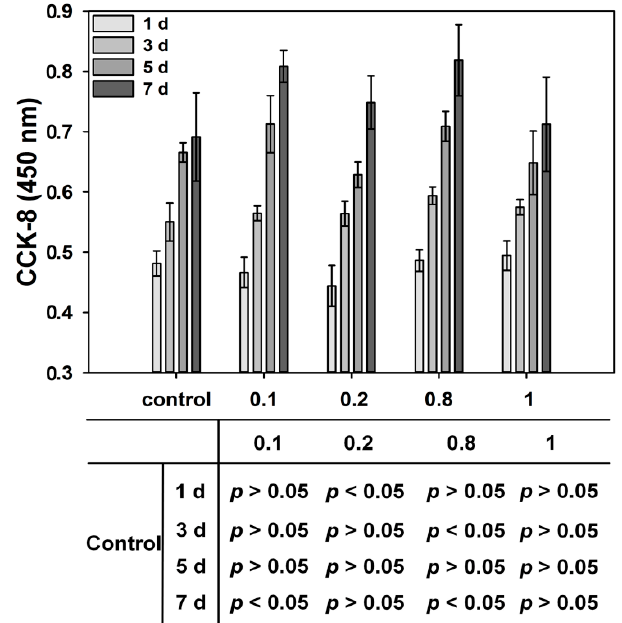
Figure 7. Cell proliferation of MC3T3-E1 cells cultured with different concentrations of Rod-CC NPs for one, three, five, and seven days. Table shows pair-wise comparison results of each group analyzed by Student-Newman–Keuls post hoc comparison test.